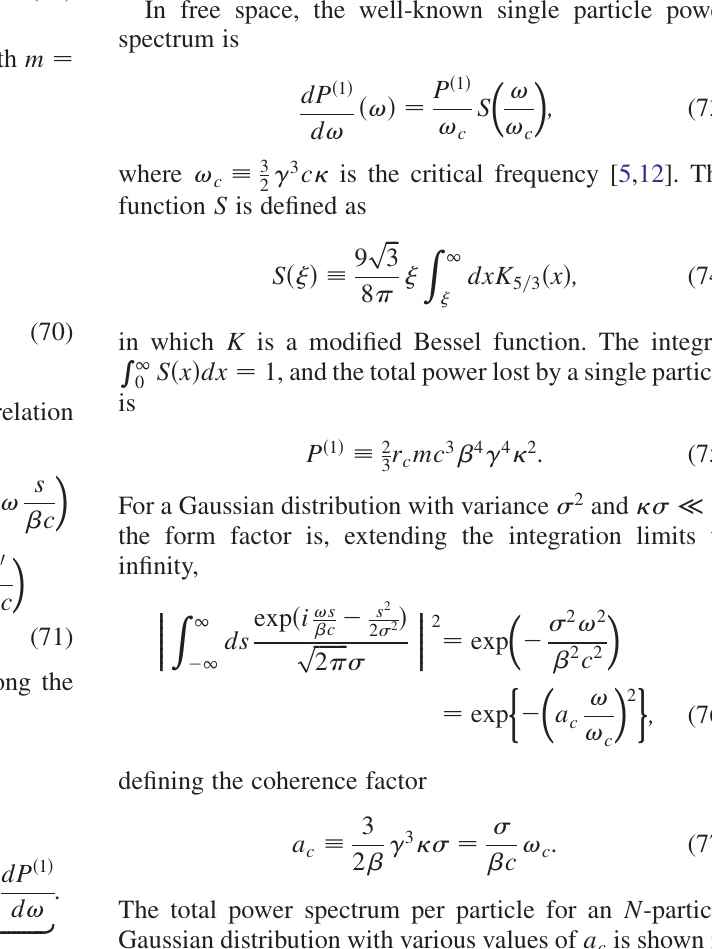
FIG. 16. The power spectrum in Eq. (72), per particle, using a Gaussian form factor with various values of the coherence parameter a c ¼ 2 p , defined in Eq. (77). The lower frequencies are enhanced by a factor of N , and in this example N ¼ 10 9 while the second is the coherent power spectrum. The squared integral is called the form factor.